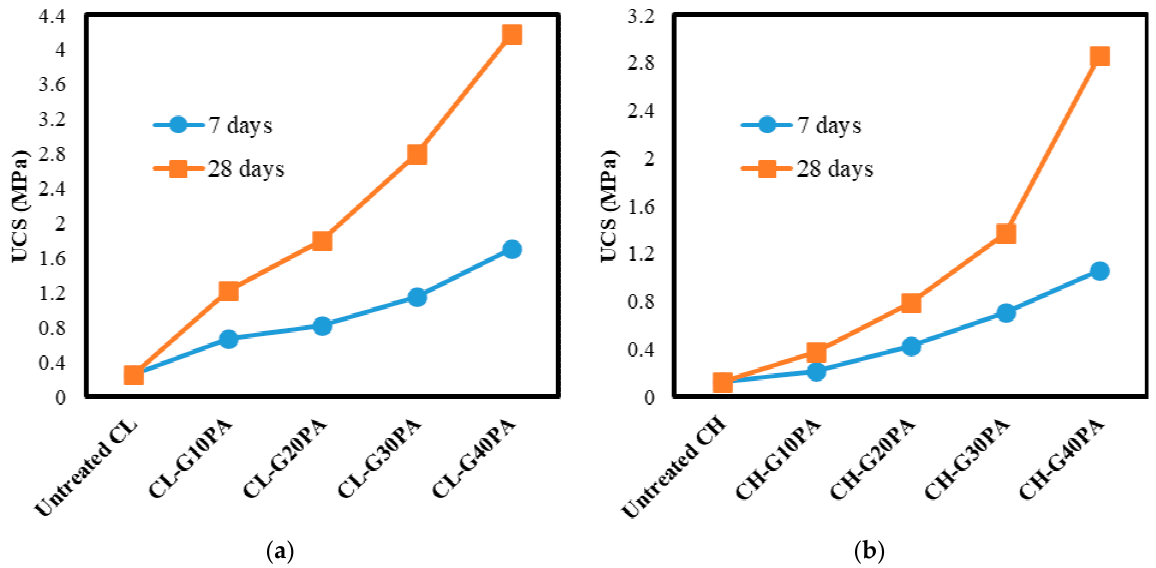
Figure 5. Compressive strength (UCS) of untreated and treated samples: ( a ) CL, ( b ) CH.